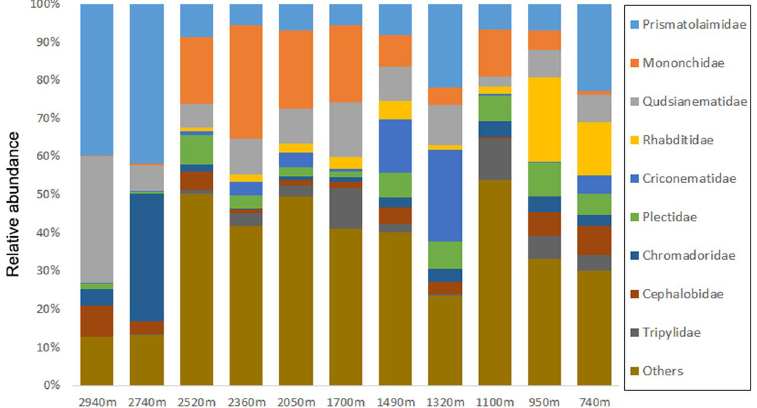
Figure 1. Relative abundance (%) of nematode families on different elevational isoclines, based on total sequence reads.